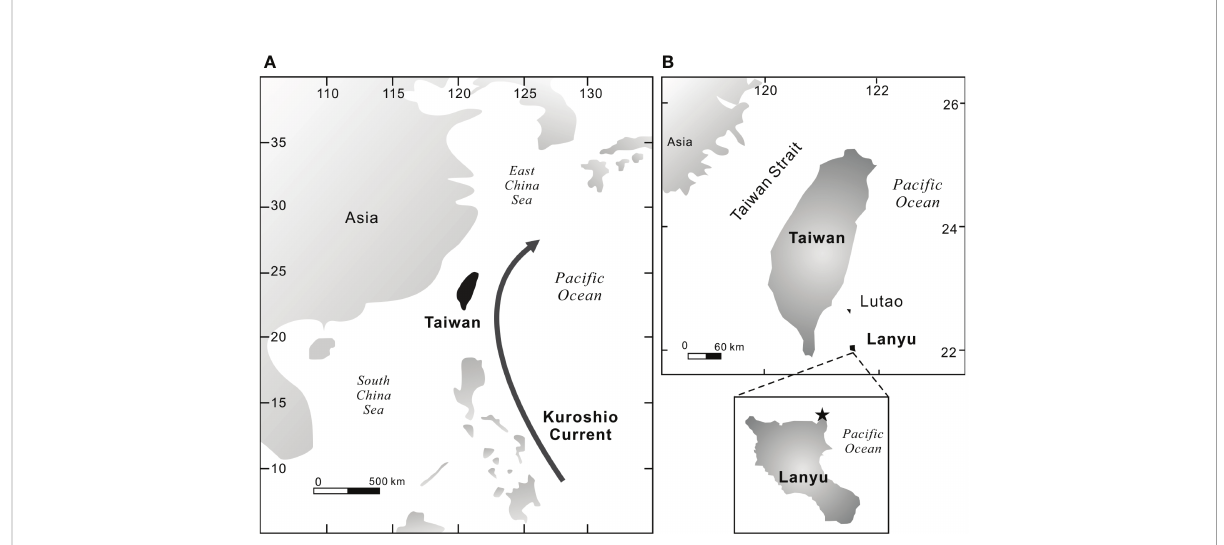
FIGURE 2 Location of the Lanyu Islet. This map shows (A) the path of the Kuroshio Current and the East Asian Monsoon and (B) the coral coring site off NE Lanyu